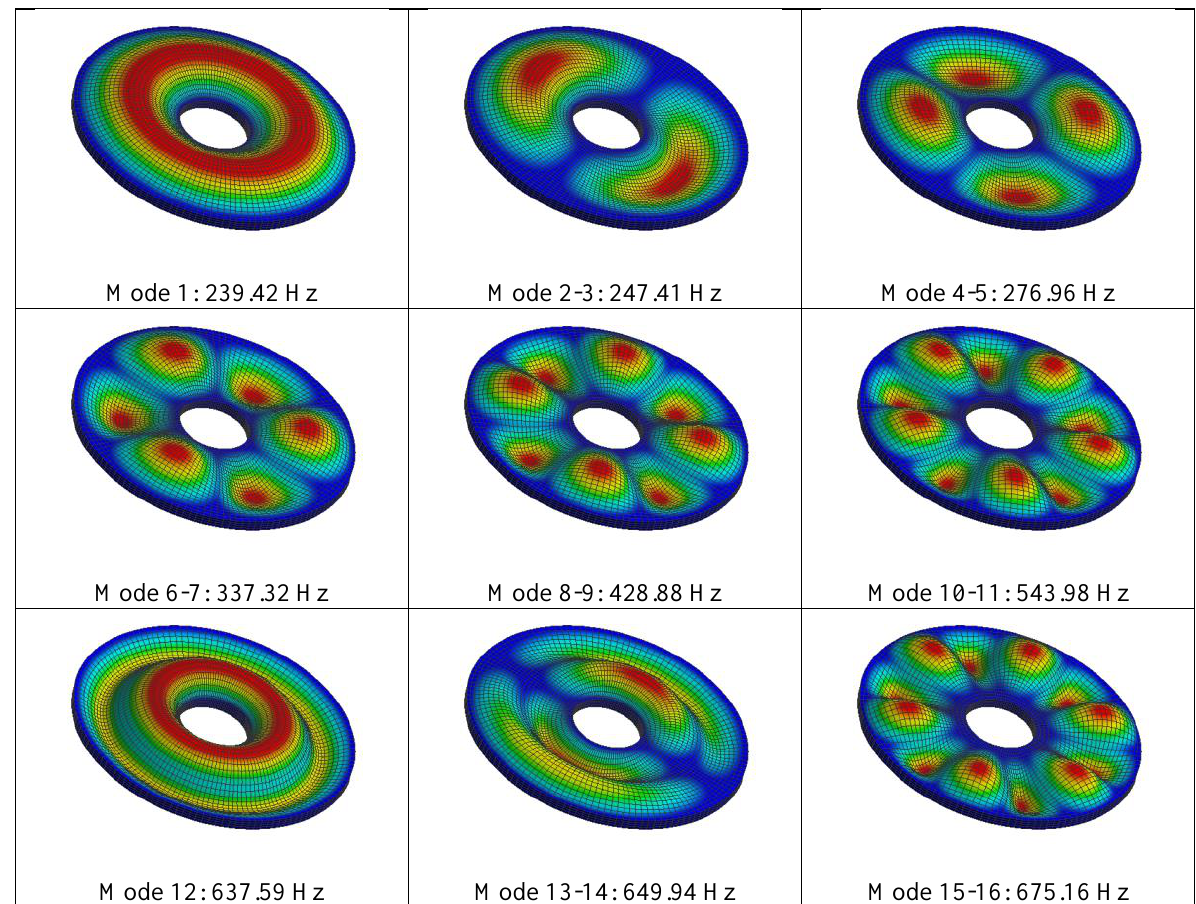
Figure 6: Frequency and mode shapes of annular plate with C-C edges (h=10cm, R 1 =50 cm, R 2 =200 cm, ρ =7800 kg/m 3 , E=2.1 × 10 11 Pa, ν